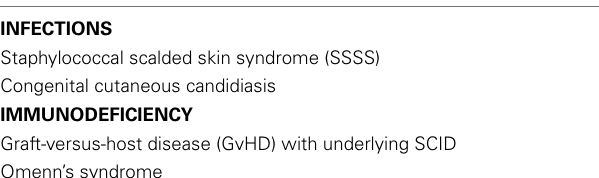
Table 3 | Differential diagnosis of erythroderma presenting in the neonatal